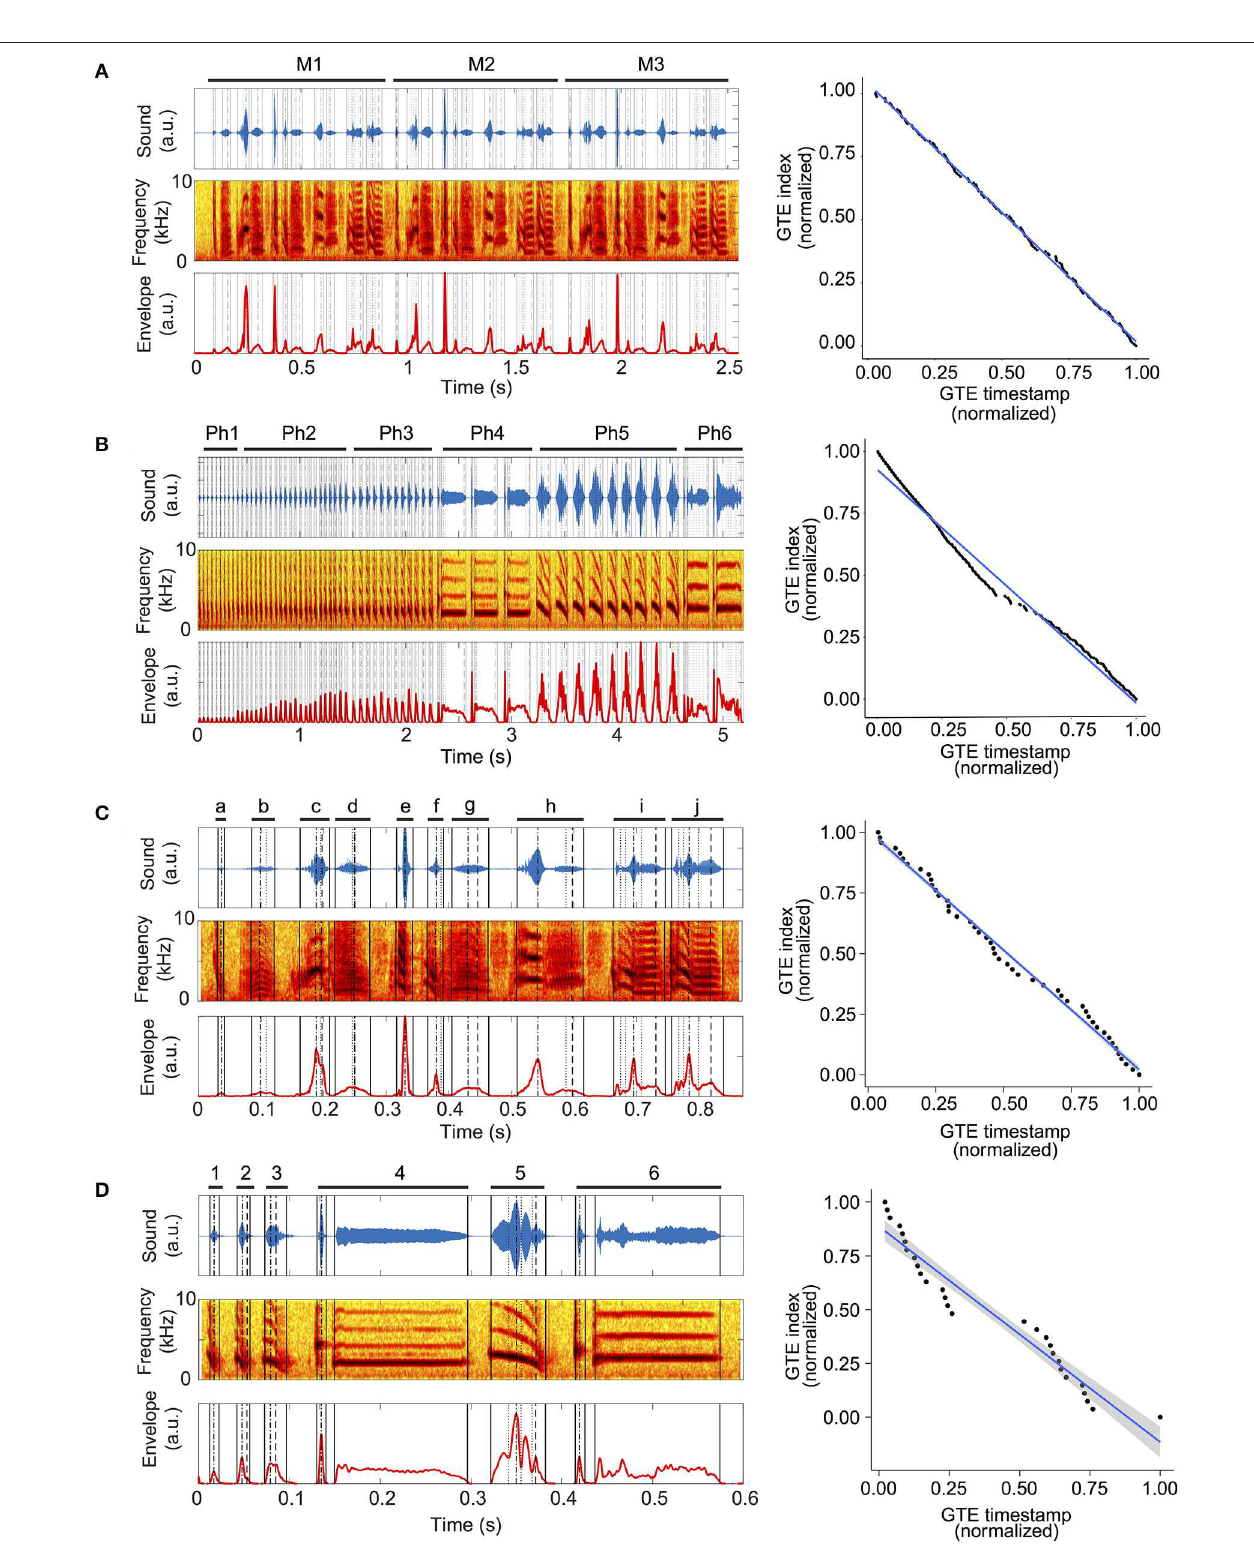
FIGURE 1 | GTEs in zebra finch and canary songs. (A) Left top: sound of a zebra finch song. Labels M1–M3 and bars indicate a motif that is repeated three times during the song. Left middle: spectrogram of the song. Left bottom: envelope trace calculated from the sound in the left top panel. Vertical lines indicate